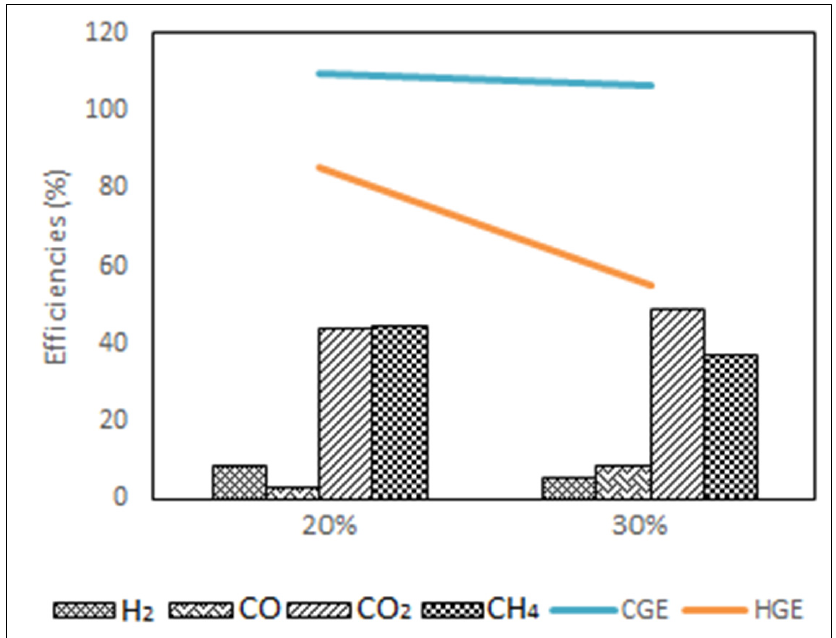
Figure 16. In fl uence of biomass loading on gas composition and process e ffi ciencies. Figure 16. Influence of biomass loading on gas composition and process efficiencies. The rise in biomass loading led to a reduction in H 2 and CH 4 yields and gasification efficiencies. The decrease in H 2 content, from 8.6 mol% to 5.8 mol%, with an increase